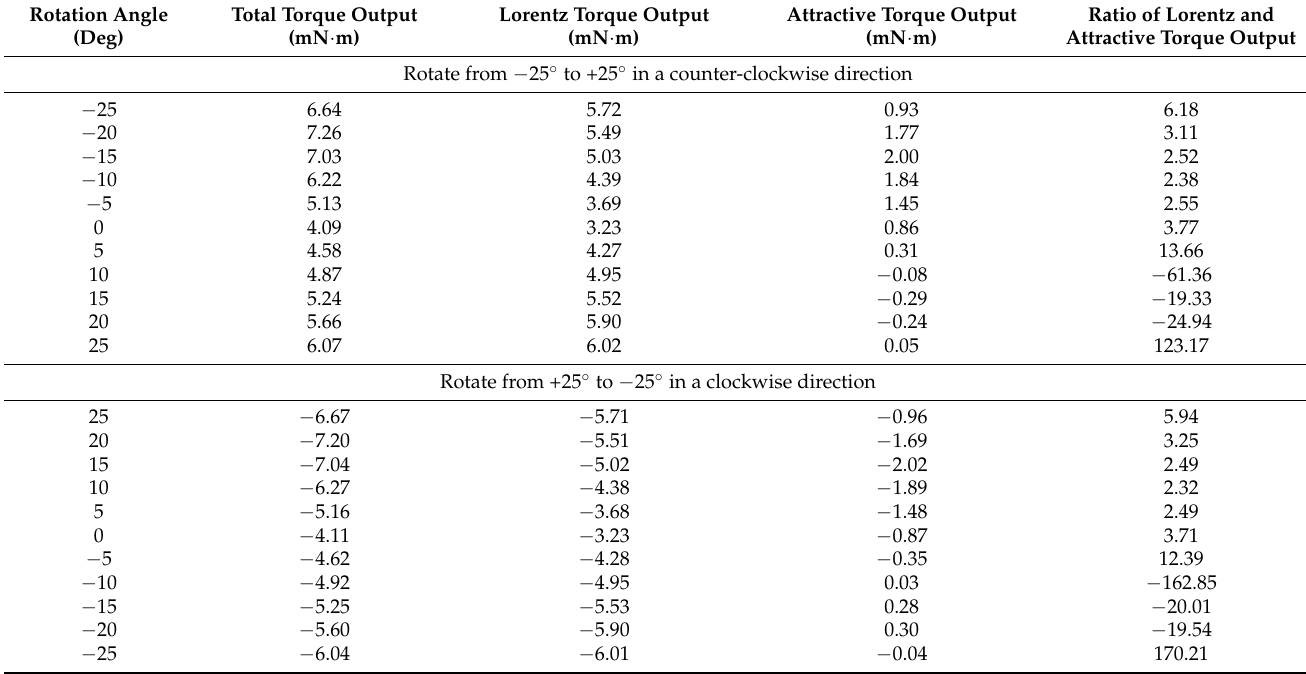
Table 4. Torque output of proposed 3-DOF spherical